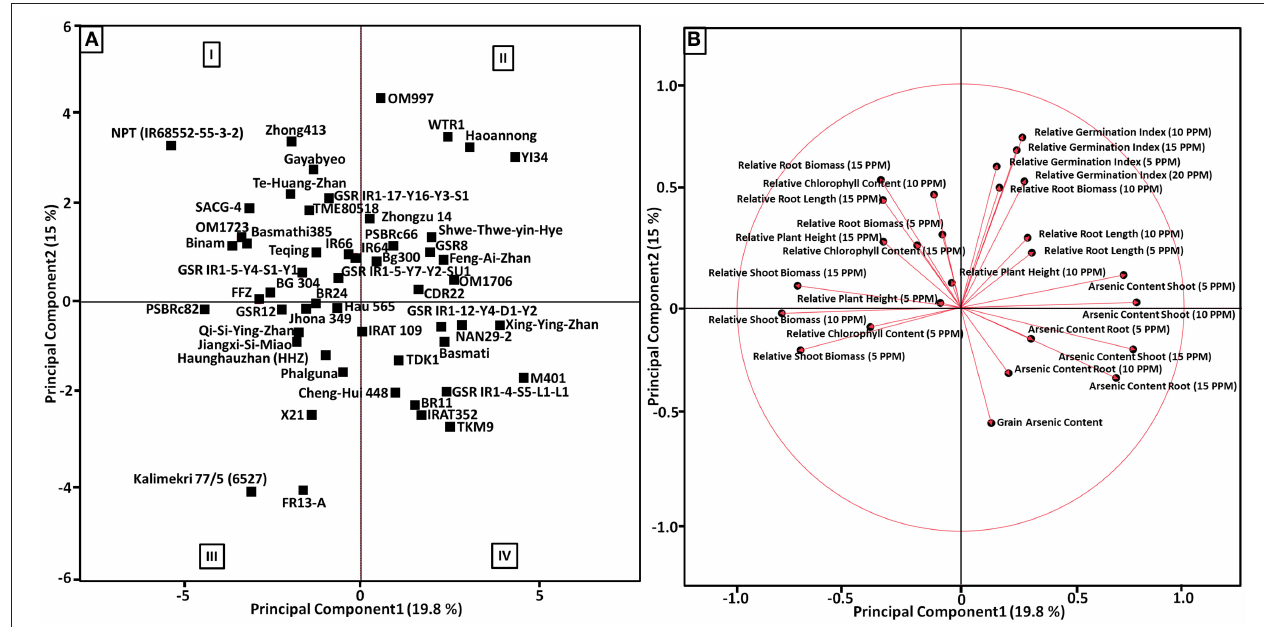
FIGURE 5 | (A) Score plot showing principal component analysis (PCA) for the first two principal component (PC) scores, PCA1 vs. PCA2 describing the morpho-physiological parameters measured for all 53 genotypes under germination tolerance, the early growth stage of rice and As accumulation characteristics. Rice genotypes with high/low scores in each tolerant category are identified in the PCA plots. (I) Genotypes with strong early development stage tolerance, moderate to high germination tolerance, and accumulating less As in root, shoot and grain. (II) Genotypes with strong germination stage tolerance, high to moderate tolerance in early development and accumulate less to moderate As in root, shoot and grain. (III) Genotypes having moderate to low tolerance in the early stages of development, and high sensitivity toward germination tolerance, and accumulating moderate to high As in root, shoot and grain. (IV) Genotypes having moderate to high sensitivity toward germination tolerance, high sensitivity toward the early stages of development, and accumulating high As in root, shoot and grain. (B) Loading plot showing the vector coefficients of As-related trait variables for the first principal component vs. the coefficient for the second principal